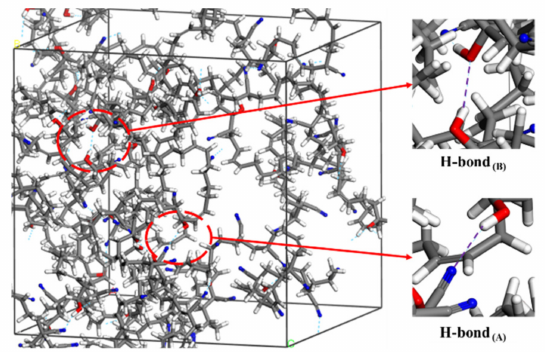
Figure 7. Two types of H-bond in OH-NBR model.